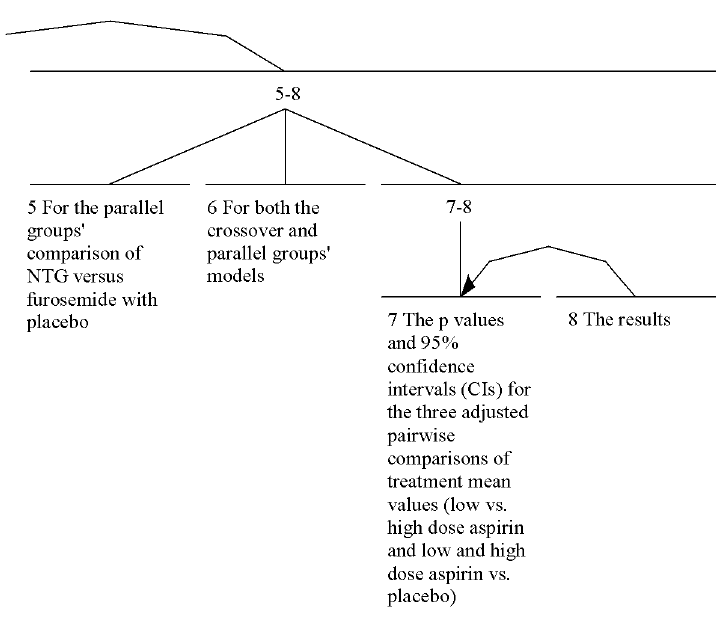
Figure 6. Theme pattern in the fourth subsection of Methods In the ST, the same thematic pattern is observed. Unit 7 is maintained in the periphrastic passive with the same order of elements. Nevertheless, units 5 and 6 are rendered as reflexive passives, and thus verbs and Participants shift positions; despite the shift, the Circumstances remain thematic: (18a) ST: For the parallel groups’ comparison of NTG versus furosemide with placebo , a covariance pattern, mixed